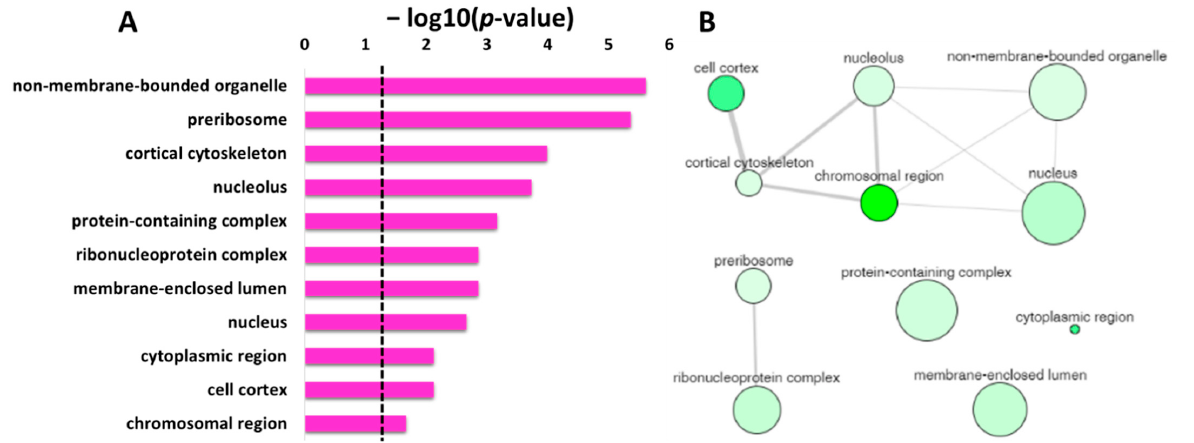
Figure 5. REVIGO analysis for the non-redundant enrichment items in the GO cellular component.